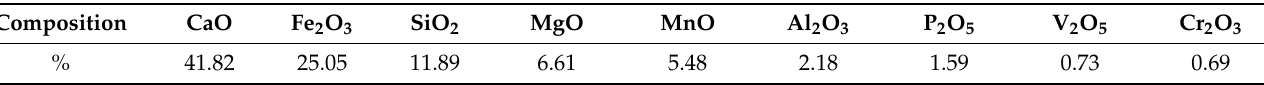
Table 1. Composition of raw steel